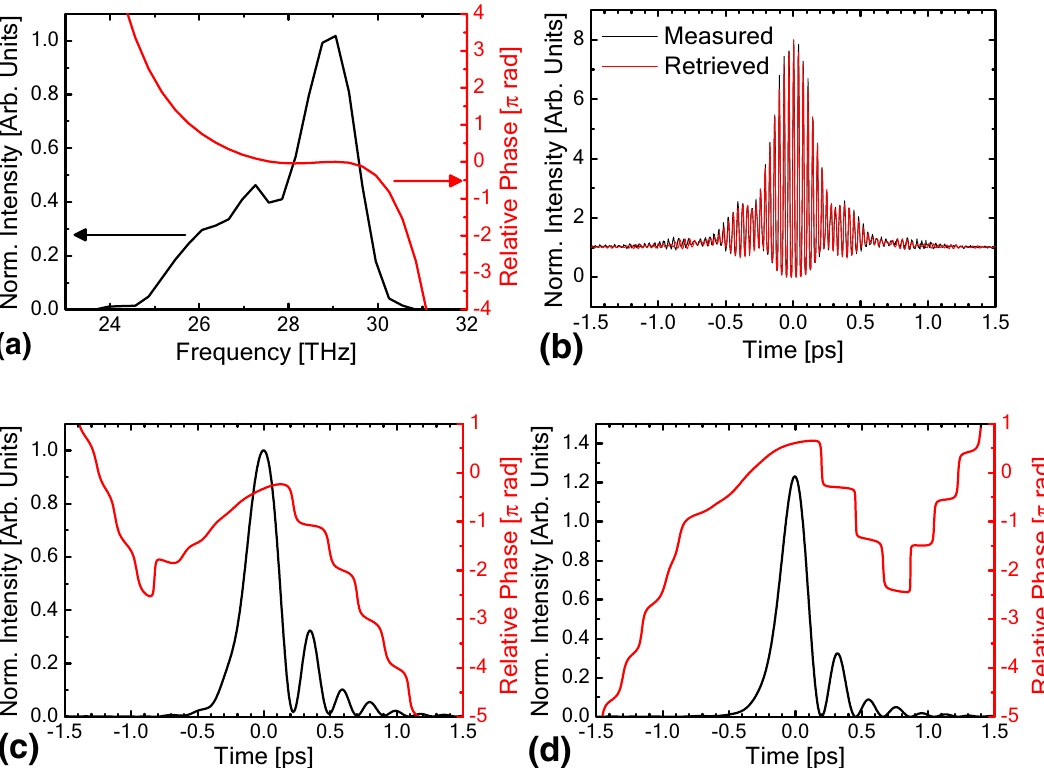
Figure 1. ( a ) FEL spectrum deduced by Fourier transformation of the LA trace and retrieved relative spectral phase. ( b ) Measured and retrieved FRAC traces. ( c ) Retrieved pulse structure and relative phase. ( d ) Retrieved pulse structure and relative phase after subtraction of the dispersion effect of the refractive optical components in the beam